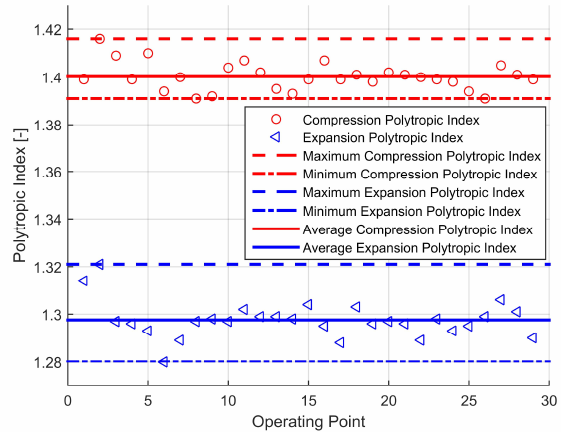
Figure 16. Compression and expansion polytropic index results for the 29 known operating conditions.